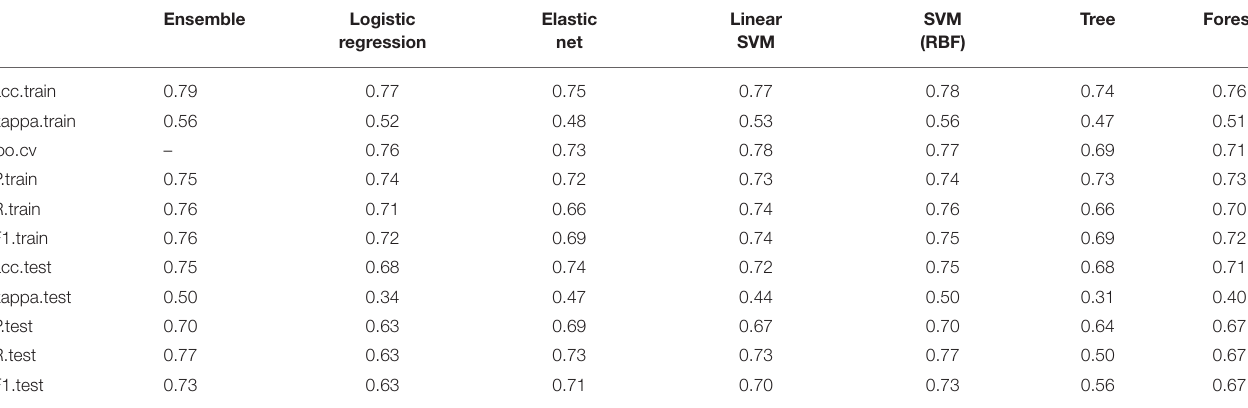
TABLE 8 | Summary of the prediction measures of the best predictors.